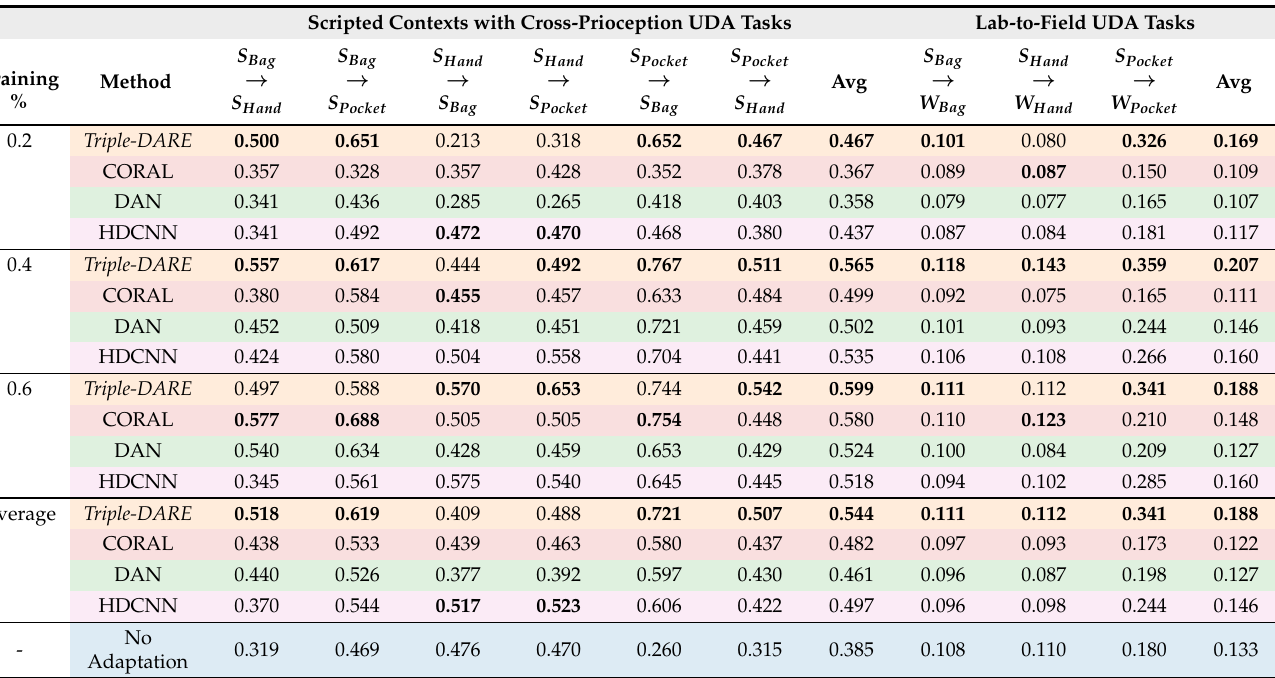
Table 7. F-1 scores—Using variable amounts of source labels to compare diverse UDA methods for a variety of tasks.